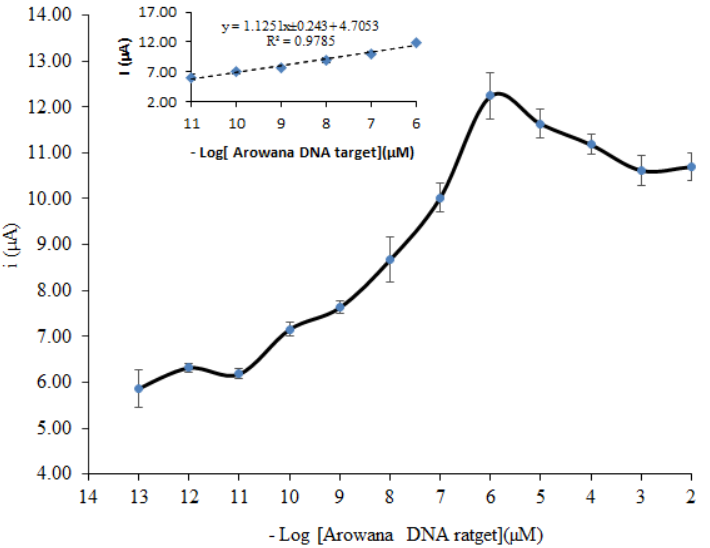
Figure 10. Calibration curve of electrochemical DNA biosensor using 5 μ M targets hybridized with different concentrations of target from 1 × 10 − 13 μ M to 1 × 10 − 2 μ M. The biosensors were run in 10 mM PBS at pH 7 and 0.1 M KCl using a scan rate of 0.1 Vs − 1.